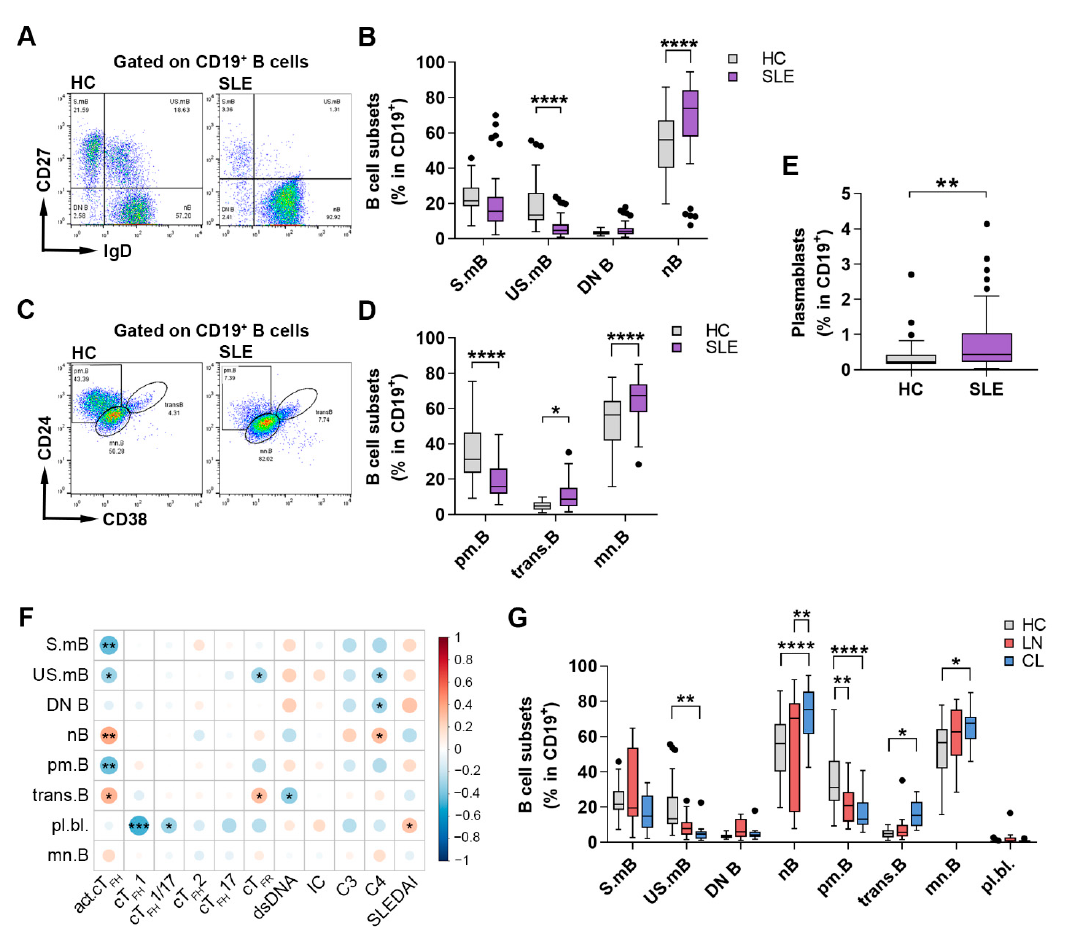
19.41 ± 13.50%; p < 0.0001) (Figure 3B), as well as primarily memory B cells (18.87 ± 9.99% vs. 36.90 ± 15.99%; p < 0.0001) (Figure 3D), were significantly diminished in SLE patients compared to controls. On the other hand, patients with SLE had a significantly increased frequency of plasmablasts compared to control subjects (0.79 ± 0.89 vs. 0.38 ± 0.49%; p = 0.0056) (Figure 3E).